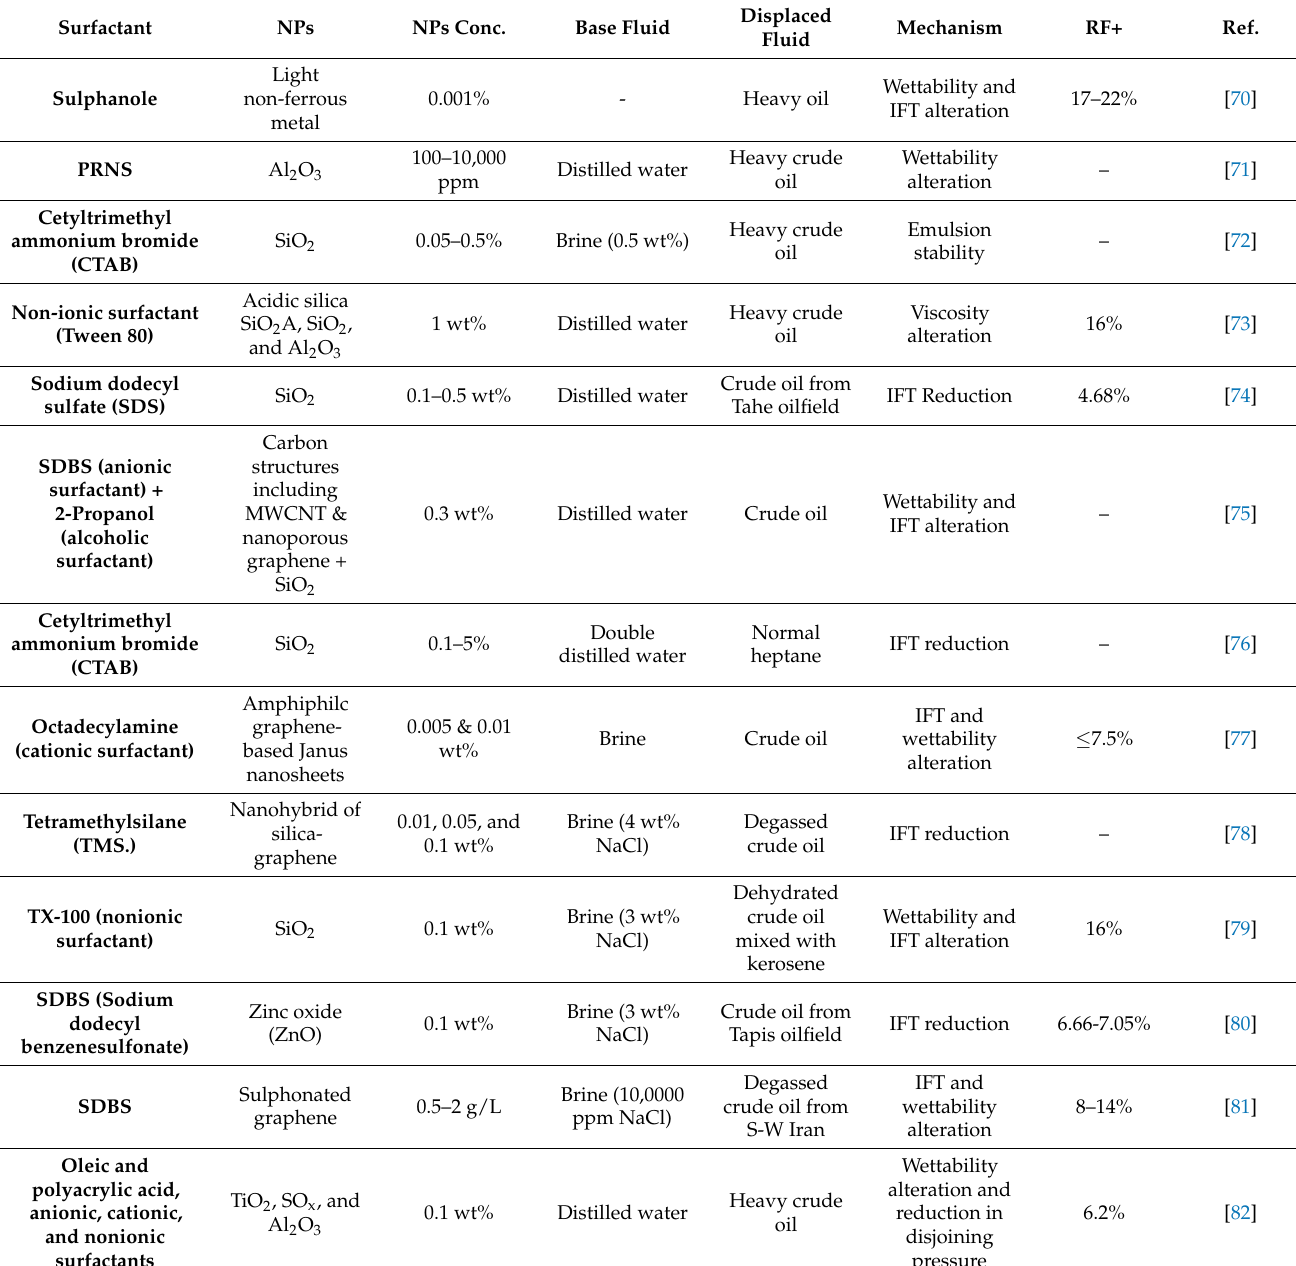
Table 2. Previous studies on the performance of surfactant